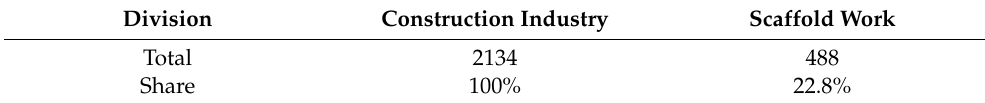
Table 1. Fatalities related to scaffold work in Korea for 5 years (2013–2017).